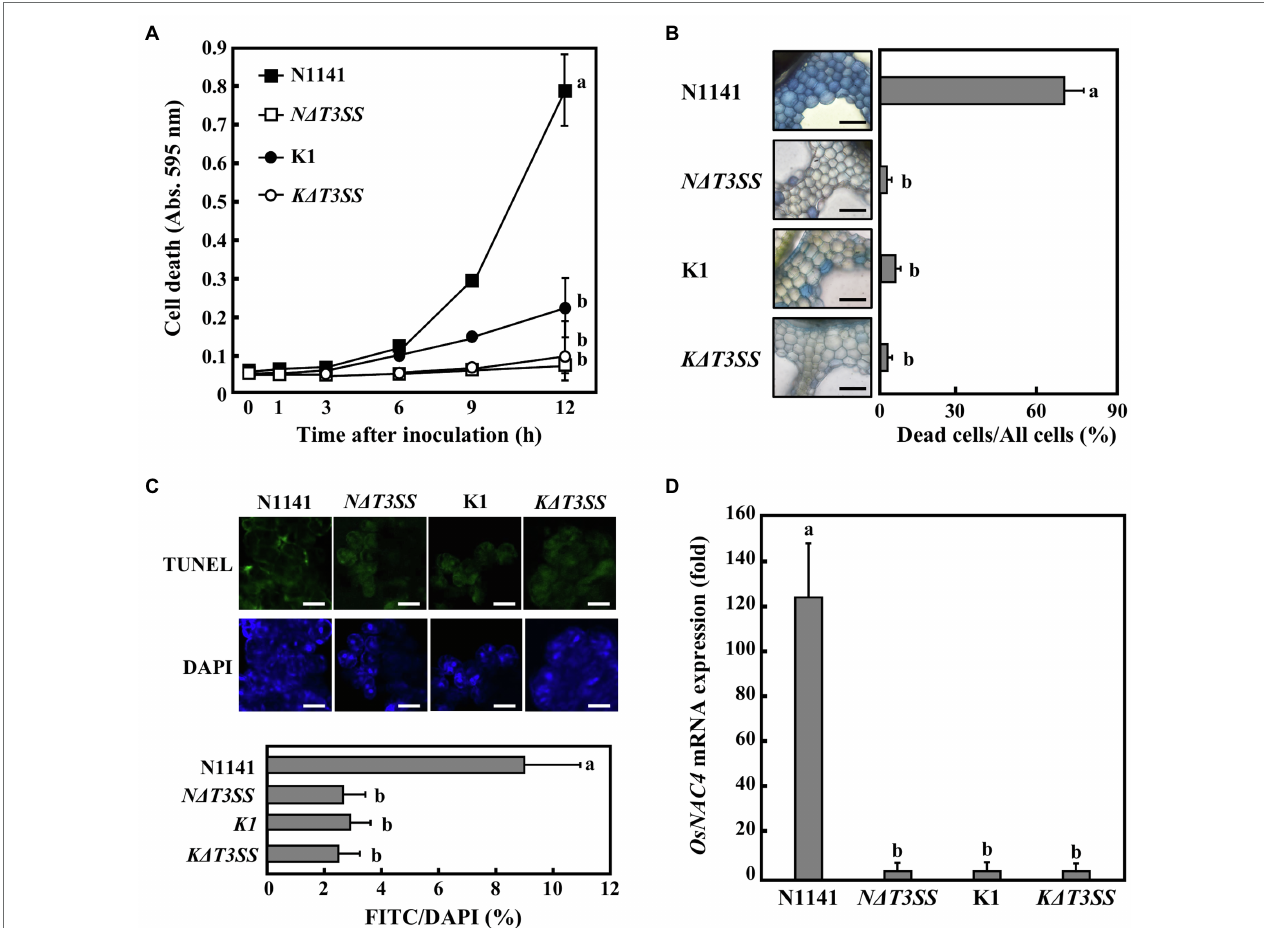
FIGURE 1 | Rice hypersensitive response (HR) cell death induced by each strain of Acidovolax. avenae (A) Time course of HR cell death in cultured rice cells inoculated with N1141 wild type (solid square), N Δ T3SS (open square), K1 wild type (solid circle), or K Δ T3SS (open circle). Hypersensitive response cell death was detected by Evans blue staining. That time point values without letters indicate no statistical significance. (B) Induction of HR cell death in leaf sheath sections. Rice sheath cross-sections were inoculated with N1141, N Δ T3SS , K1, and K Δ T3SS , and 6 h after inoculation, Evans blue staining was performed. Bar represents 100 μ m. Left graph shows the percentage of dead cell in leaf sheath sections. Each determination was done with at least 100 cells in each experiment. (C) Terminal deoxynucleotidyl transferase-mediated dUTP nick-end labeling (TUNEL) staining of each strain-inoculated cultured rice cells. Upper photographs represent TUNEL staining cell images of cultured rice cells inoculated with N1141 wild type, N Δ T3SS , K1 wild type, or K Δ T3SS . Lower photographs represent DAPI staining cell images of cultured rice cells inoculated with N1141 wild type, N Δ T3SS , K1 wild type, or K Δ T3SS . Scale bar in photographs represents 10 μ m. Lower graph represents percentage of TUNEL-positive nuclei in cultured rice cells inoculated with each strain. The percentage of TUNEL-positive nuclei was determined by counting nuclei within 10 individual fields. Each determination was done with at least 1,000 nuclei in each of three independent experiments. (D) OsNAC4 mRNA levels in cultured rice cells inoculated with N1141, N Δ T3SS , K1, or K Δ T3SS . The x-axis represents the fold change in mRNA levels relative to those in cultured cells prior to treatment. Error bars in all figures represent standard deviation of three independent experiments. Values followed by a different letter in figures were significantly different according to Tukey-Kramer test ( p <